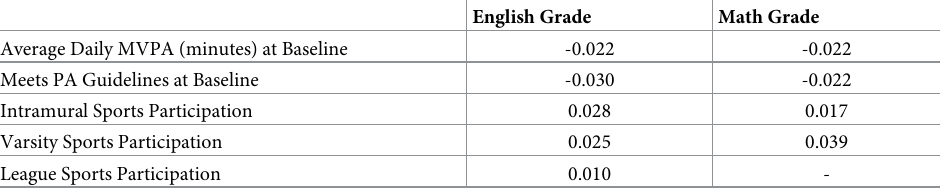
Coefficients are Cohen’s f values based on un-clustered